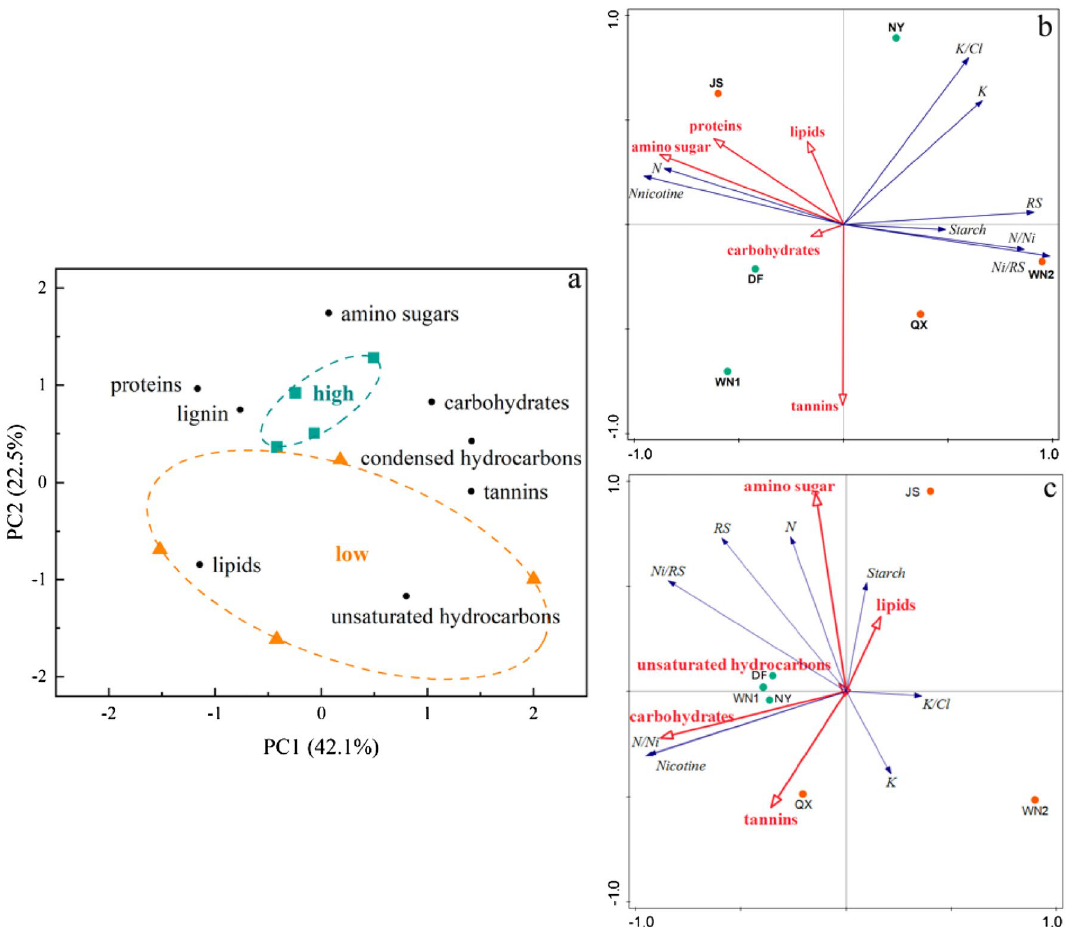
Figure 7. PCA and RDA results based on tobacco chemical composition and SOM compounds. ( a ) PCA of common compounds and their types. ( b ) Ordination biplot based on RDA of tobacco chemical composition and SOM compounds. Tannins and amino sugar were identified as significant factors and included in the model. ( c ) Ordination biplot based on RDA of tobacco chemical composition scores and SOM compounds. Amino sugar were identified as significant factors and included in the